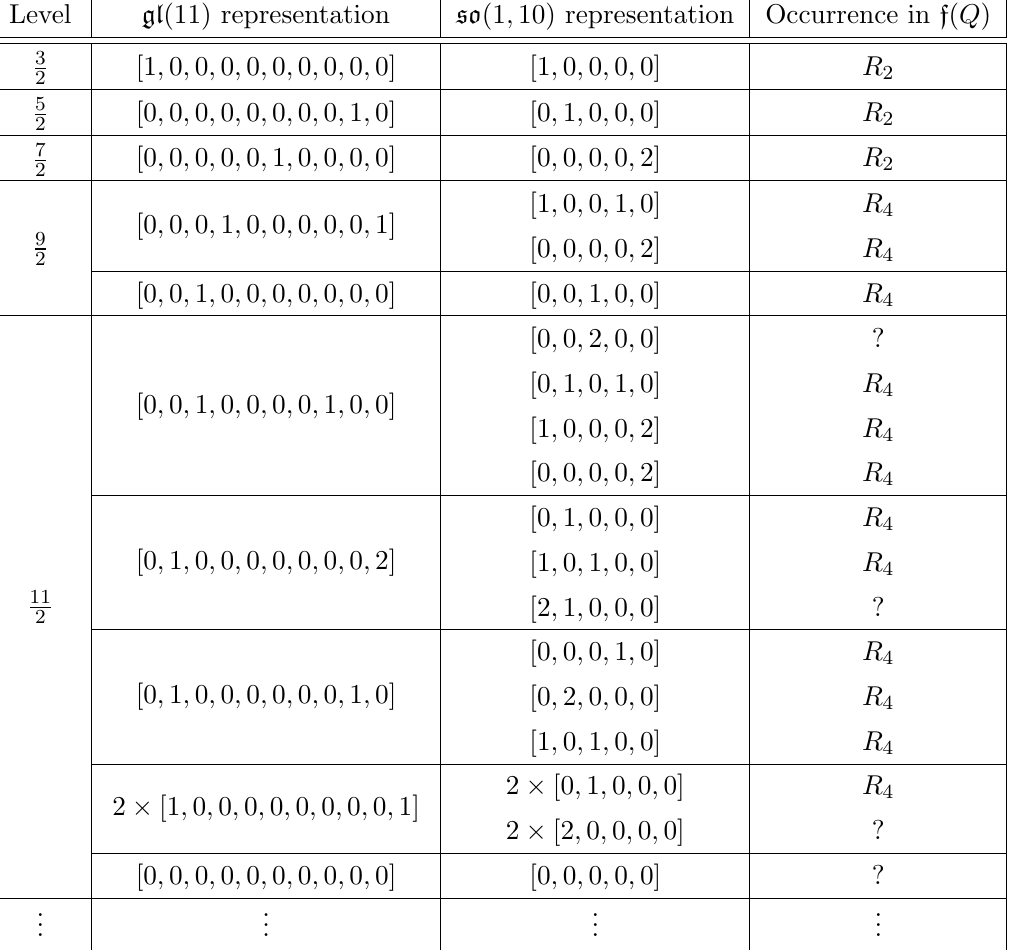
The (cid:12)rst few levels of the ‘ 1 lowest weight representation of E 11 . Level here refers to the natural grading under gl (11) (cid:26) E 11 . The last column lists a possible match with the even levels of the free Lie algebra in table